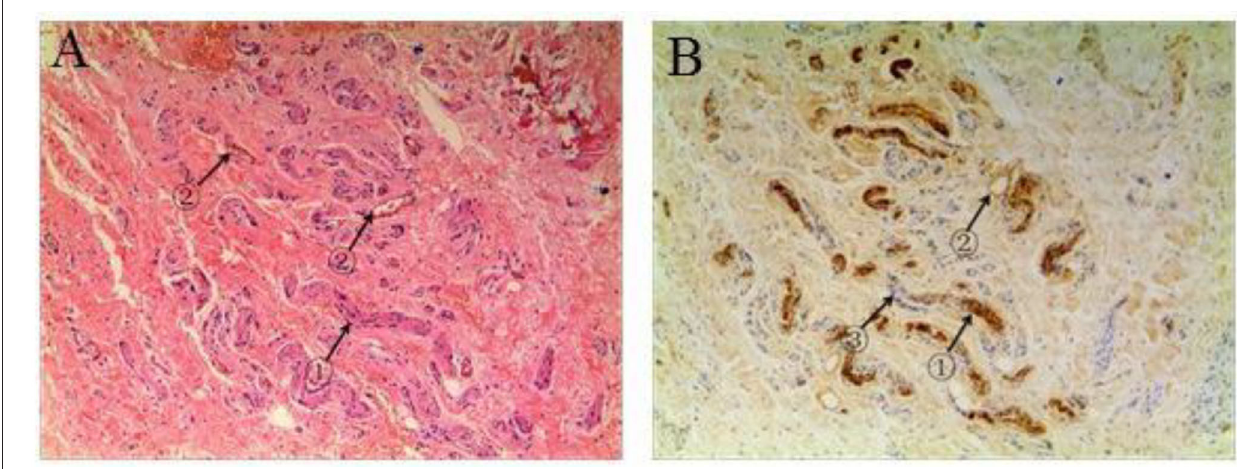
FIGURE 2 | Staining for nerve plexus distribution in the superficial fascia dartos of the penis. (A) A representative hematoxylin and eosin (H&E) staining in a concealed penis (CP) patient showing ‹ nerve and › blood vessels. (B) A representative S-100 positive straining of a CP patient showing ‹ nerve, › adipocyte, and fi nucleus of vascular smooth muscle. Images under × 50 visual field.